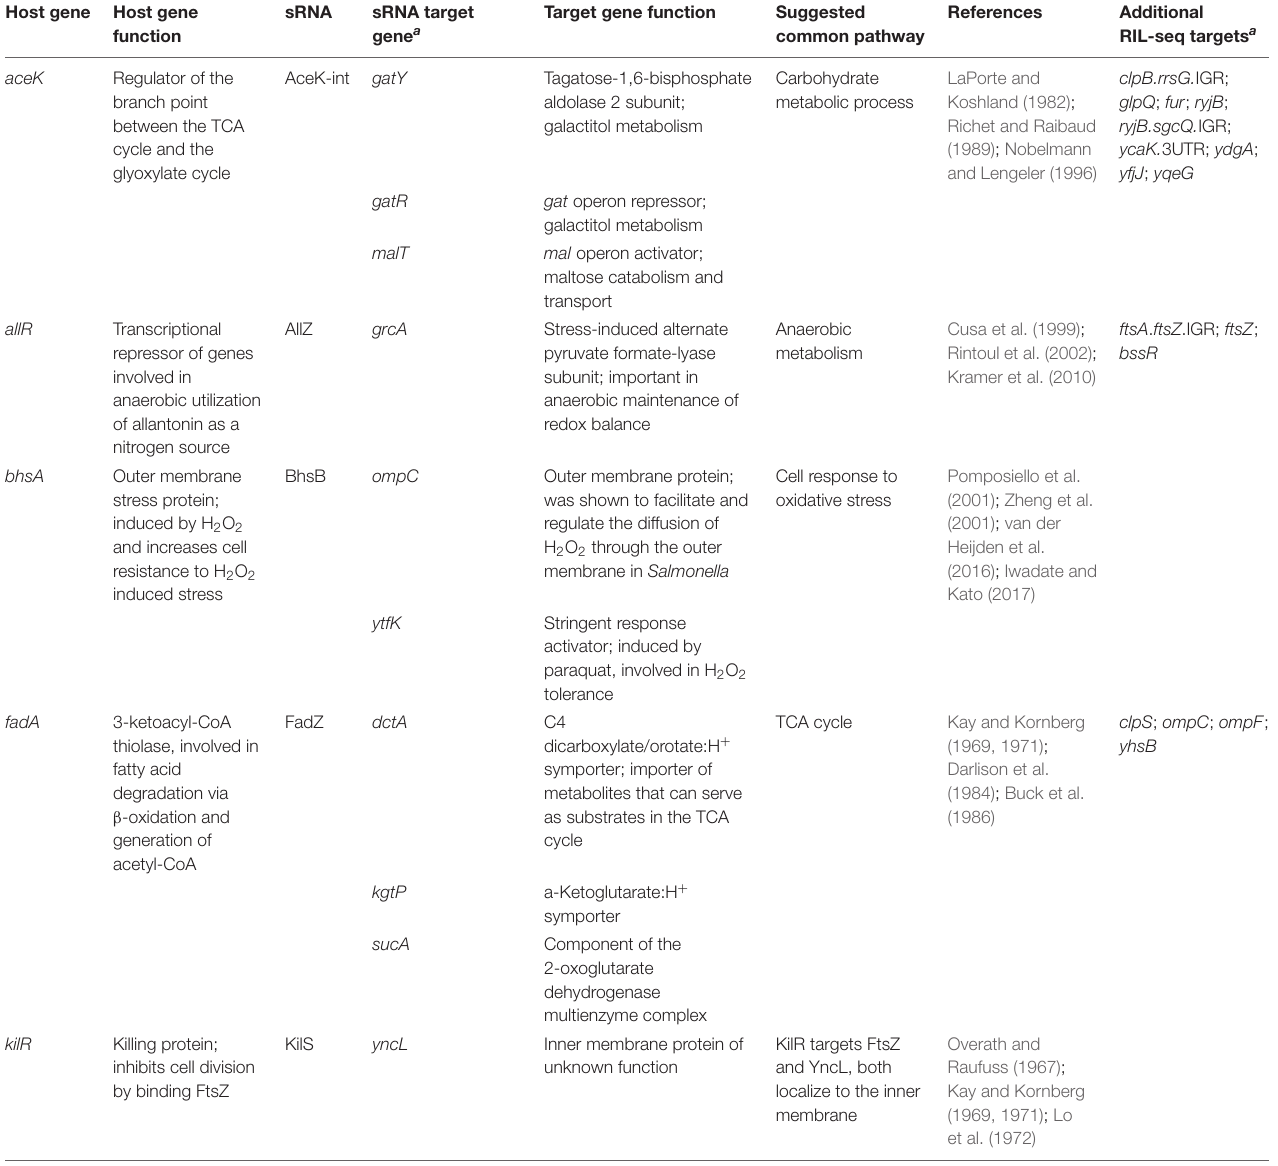
TABLE 4 | Common pathways involving the host genes of novel sRNAs and their